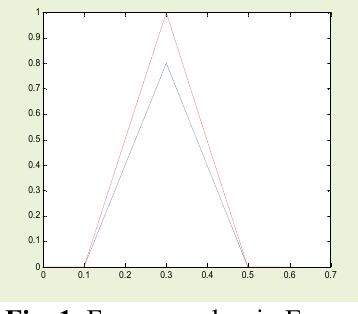
Fig. 1. Fuzzy number in Example